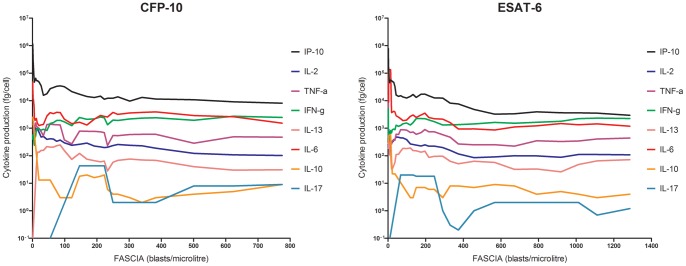
Cytokine results from patients with verified active TB, after stimulation with CFP-10 (2 A) and ESAT-6 (2 B), in relation to cell proliferation.The data are presented as graphs with the number of lymphoblasts/μl on the X-axis and the level of cytokine production/cell (fg/cell) on the Y-axis. These graphs show lower levels of cytokines produced per cell, in strong responses, except for IFN-γ, where levels rise accordingly, although a few outliers influence ESAT-6 results for low levels of lymphoblasts/µl.